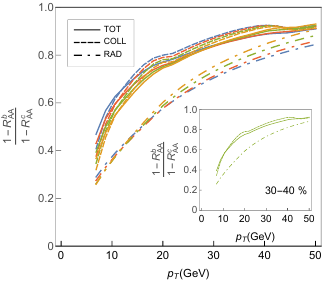
Figure 4. Numerical verification of (1 R b R c ) / (1 ) to- AA AA − − R c ) as an adequate observable for mass extrac- AA tion from collisional contribution, through com- parison with experimental data (for more details 40% cen- − see [11]. Figure adapted from